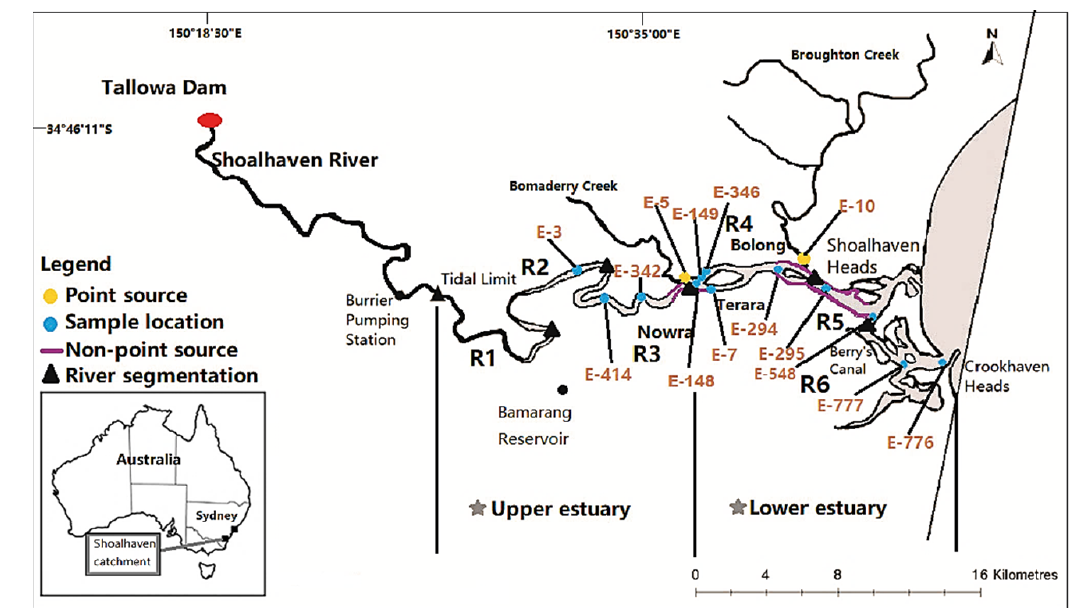
Figure 1. The Shoalhaven River downstream of Tallowa Dam following; Bomaderry Creek and Broughton Creek provide point sources (yellow points). The various estuary reaches (R1–R6) are delineated by the black triangles. Blue points with E labels: water sampling sites.